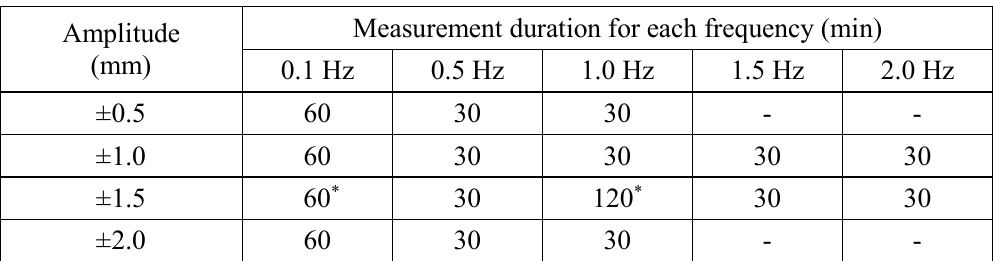
Table I. Parameters in amplitude, frequency and duration of the oscillation experiments . The asterisk (*) signifies that some repetition was carried